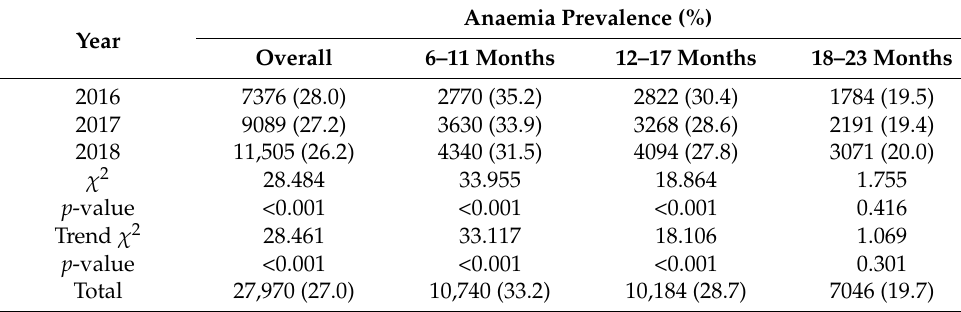
Table 2. Trends in prevalence of anaemia (%) by age in 2016, 2017, and 2018.